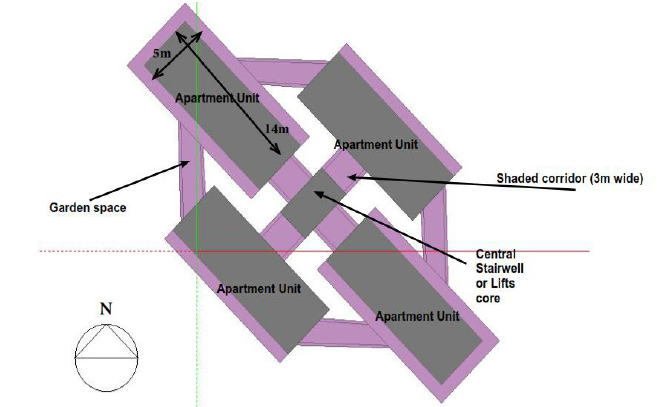
Fig. 8. Option 3 plan